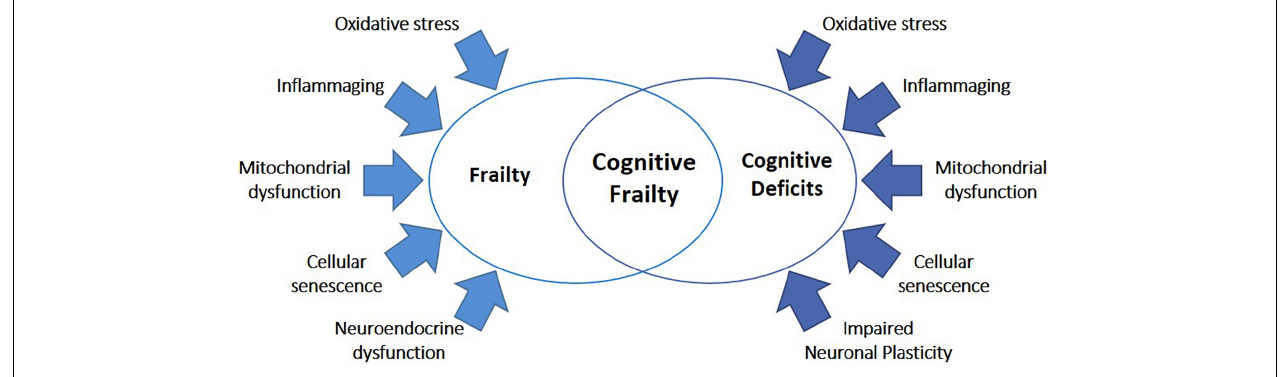
FIGURE 2 | Common mechanisms underlying frailty and cognitive deficits. The high majority of mechanisms known to be involved in frailty were also implicated in cognitive diseases, including oxidative stress, inflammaging, mitochondrial dysfunction, cellular senescence, neuroendocrine dysfunctions, and impaired neuronal